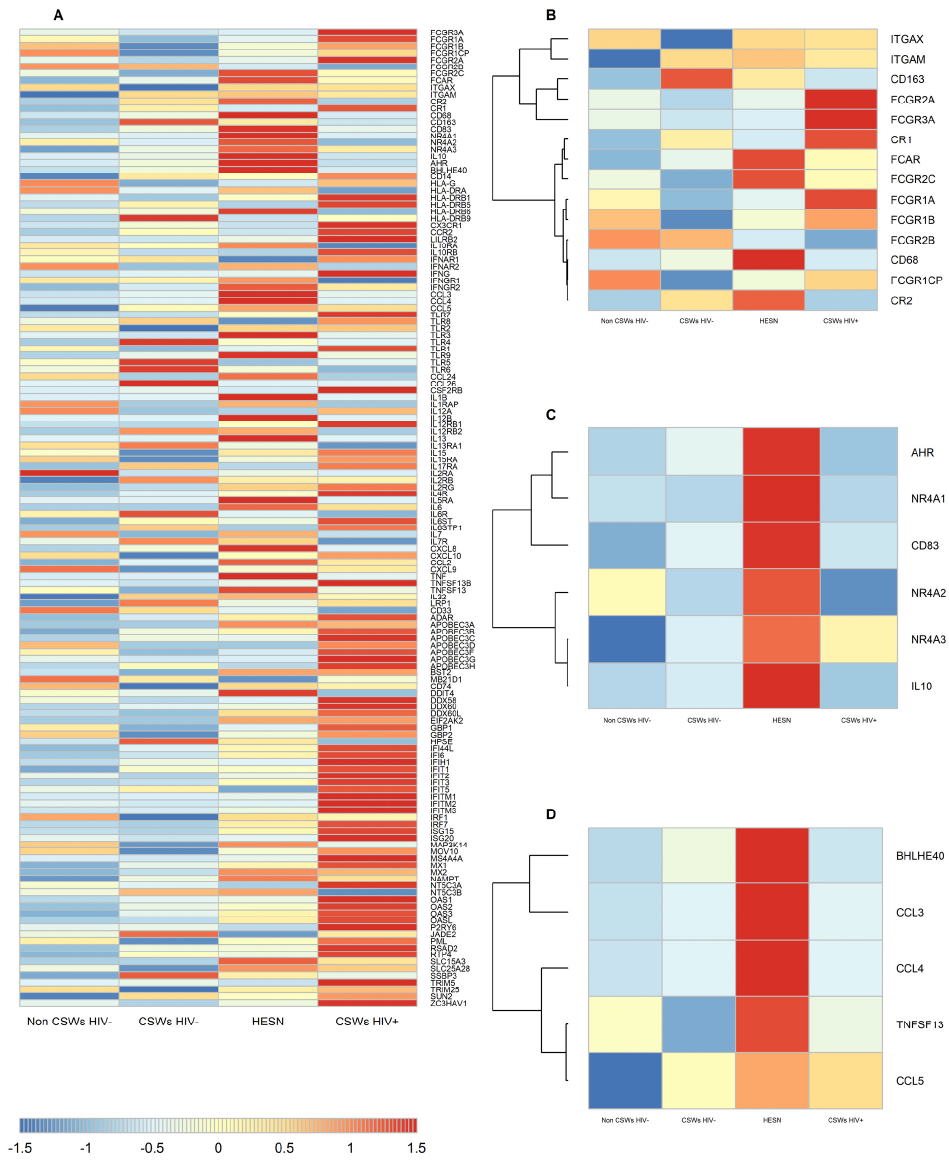
Figure 1. Selected transcriptomic analyses by RNA-Seq of total sorted live blood monocytes. ( A ) The heatmap shows total live monocytes expression levels of gene transcripts, the panel being selected based on our previous observations with the Beninese cohort [3–5] and the gene signature associated with protective vaccine regimen [28,29]. ( B ) Selected gene transcripts clustered for effector function. ( C ) Selected gene transcripts clustered for regulation markers. ( D ) Selected gene transcripts clustered for protection. Data are presented as the mean value of samples from three non-CSWs HIV- (HIV-1-uninfected control women from the general population), three CSWs HIV- (HIV-1-uninfected 2.5–5-year CSWs “early HESNs”), four HESNs (HIV-1-uninfected ≥ 10 years CSWs), and three CSWs HIV+ (HIV-1-infected